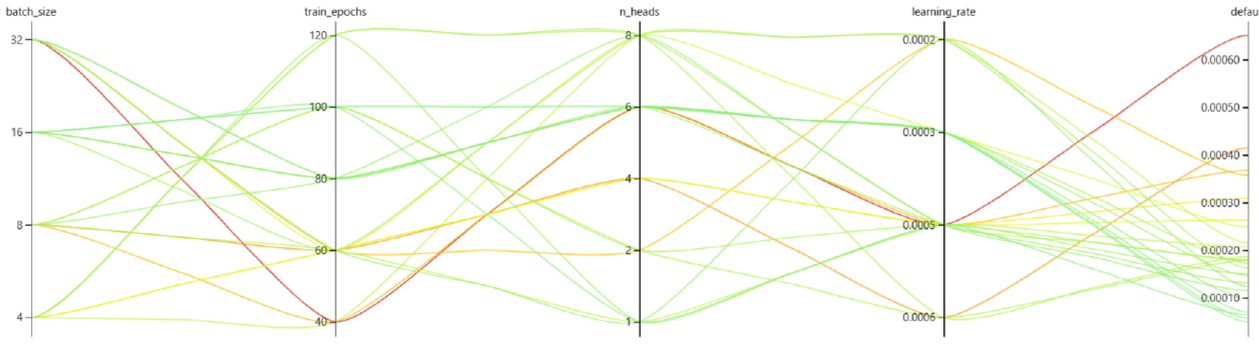
Figure 9. Results of NNI.